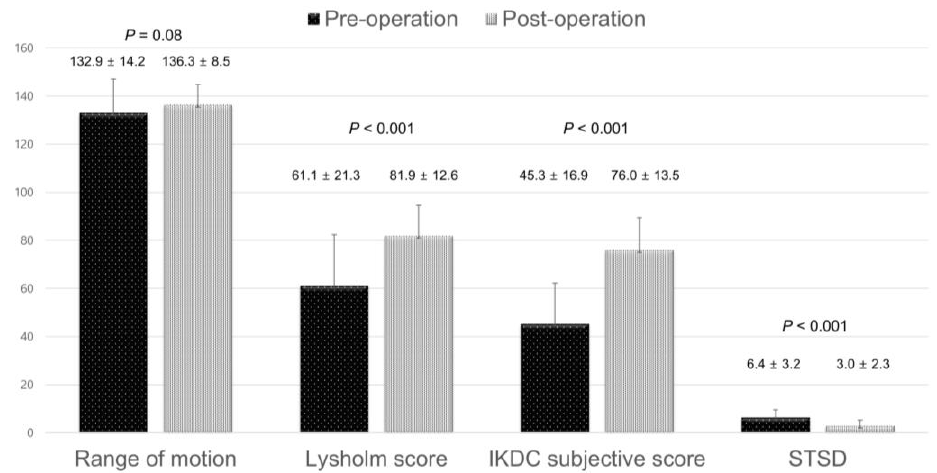
Figure 7. Comparison of clinical outcomes and side-to-side difference on stress radiographs between pre- and post-operation.